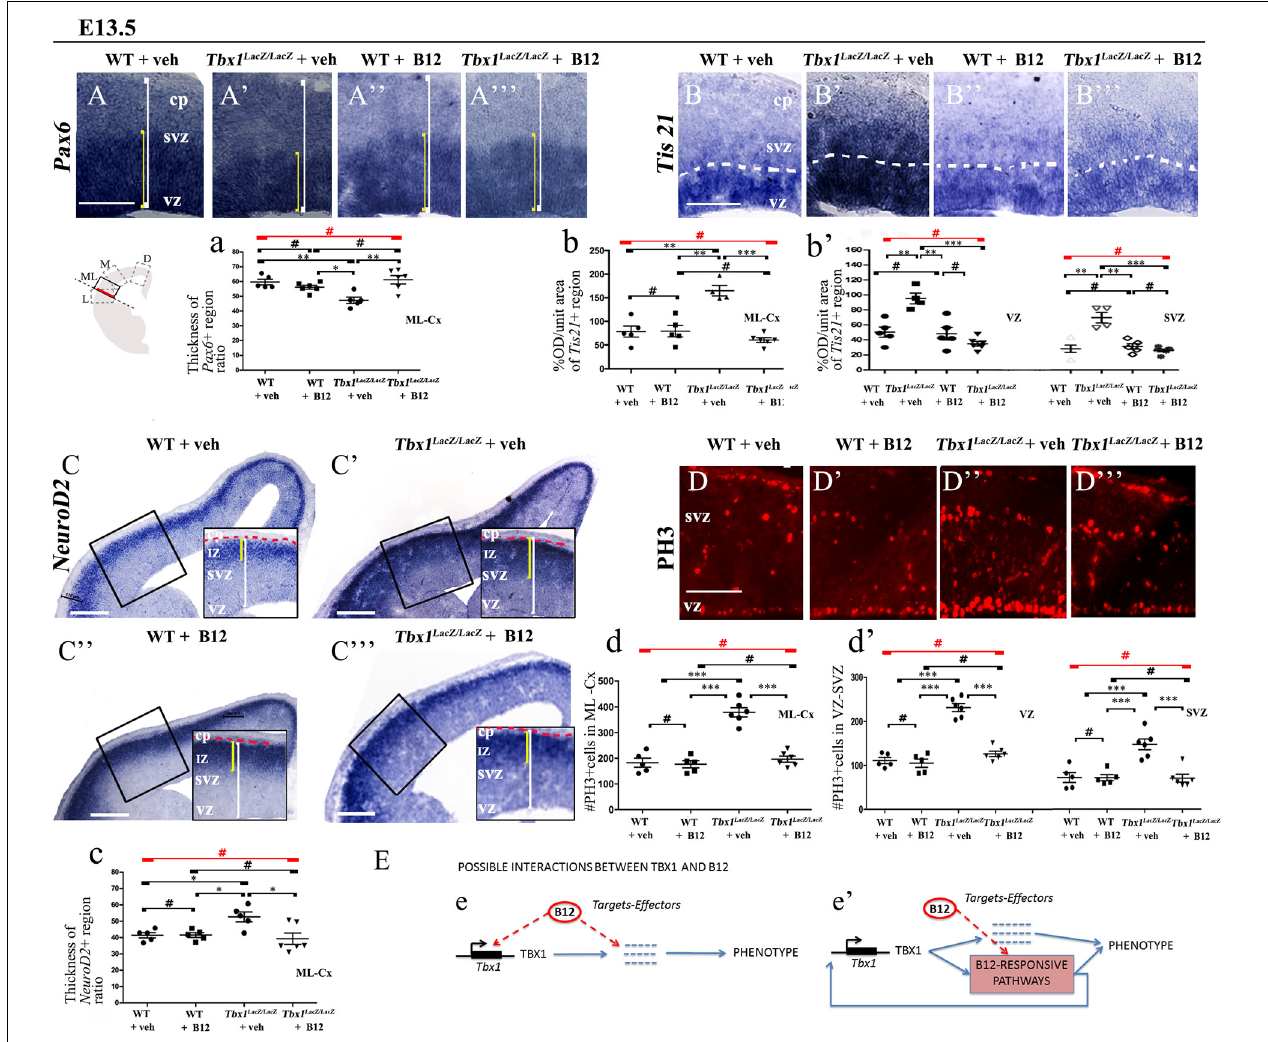
FIGURE 5 | Vitamin B12 treatment restores normal expression of cortical markers in Tbx1 homozygous embryos. All panels show coronal sections of embryonic brains at E13.5. The cartoon in (A) indicates the position of the ML-cortex in coronal brain sections (boxed area). The red line indicates the position where all measurements were made. (A,a) In situ hybridization of Pax6 (A–A”’) revealed thinning of the expression domain (yellow brackets) in vehicle-treated Tbx1 lacZ / lacZ embryos (A’) compared to WT (A,a) , which was rescued by B12 treatment (A”’,a) . (B,b,b’) In situ hybridization of Tis21 (B–B”’) showed increased expression in the ML-cortex of Tbx1 lacZ / lacZ embryos, including the VZ and SVZ (B’,b,b’) , which was rescued by B12 treatment (B”’,b,b’) . Dashed white line indicates border between the VZ and SVZ. (C,c) In situ hybridization of NeuroD2 (C–C”’) showed increased expression in the ML-cortex of Tbx1 lacZ / lacZ embryos (C’,c) and extension of the expression domain (yellow brackets) relative to the total ventricular pial thickness (white brackets), which was rescued by B12 treatment (C”’,c) . Dashed red line defines the external edge of the CP. (D,d,d’) Immunostaining for phosphohistone 3 (PH3) revealed increased mitotic activity in the proliferative zones (VZ, SVZ) of the ML-cortex of Tbx1 lacZ / lacZ embryos (D’,d,d’) , which was rescued by B12 treatment (D”’,d,d’) . (E) Alternative models of interactions between TBX1 and B12 that are consistent with the observed phenotypic rescue in Tbx1 homozygous mutants. In (e) , B12 acts by altering the expression of genes, including Tbx1, and one or more critical TBX1 targets. The latter activity is retained when Tbx1 expression is abolished. In (e’) , B12 acts downstream of TBX1, on one or more critical pathways that respond to TBX1 and has a positive feedback on Tbx1 expression. In the absence of TBX1, B12 continues to affect (activate or repress) the critical pathways. Scale bars, 100 µ m in all panels except panel C, which is 200 µ m. * P ≤ 0.05, ** P ≤ 0.01, *** P ≤ 0.001, error bars indicate ± SD, red horizontal bars with # not significant, n = 5–6 per genotype. VZ, ventricular zone; SVZ, subventricular zone; IZ, intermediate zone; CP, cortical plate; ML-Cx, medio-lateral cortex; D, dorsal; M, medial; ML, medio-lateral; L, lateral; OD, optical